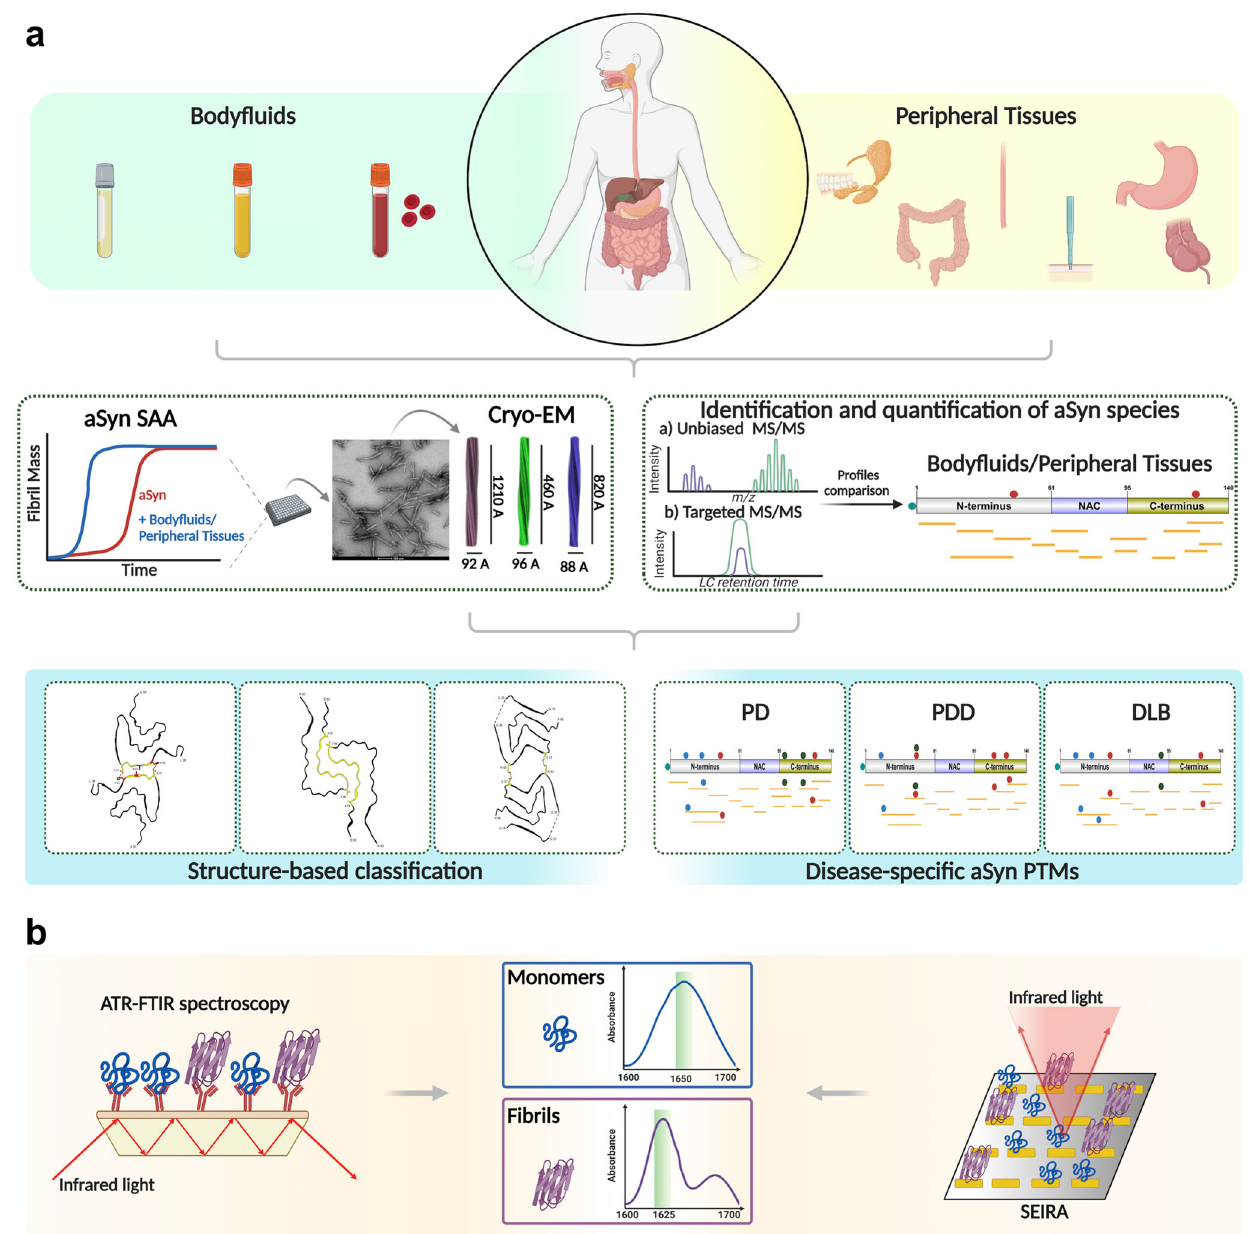
Fig. 9 Molecular and structural biomarkers of synucleinopathies. a The combination of (1) ampli fi cation and detection of minute amounts of aggregated aSyn in biological samples (i.e., aSyn SAA) coupled with cryo-EM and (2) identi fi cation and quanti fi cation of aSyn species by MS/ MS can lead to the discovery and validation of novel biomarkers, relying on structure-based classi fi cation and disease-speci fi c aSyn PTMs. Together, these approaches can open new avenues to enable differentiating PD patients from controls and from patients with other synucleinopathies. b Schematic depictions illustrating how attenuated total re fl ection-Fourier transform infrared spectroscopy (ATR-FTIR) and surface-enhanced infrared absorption spectroscopy (SEIRA) could be used as complementary approaches in this work fl ow for high- throughput structural analysis of biological samples, allowing molecular-level differentiation of a monolayer of aSyn monomers and fi brils. Created with BioRender.com and the cryo-EM structures of the aSyn fi brils depicted in the fi gure are derived from different aSyn recombinant